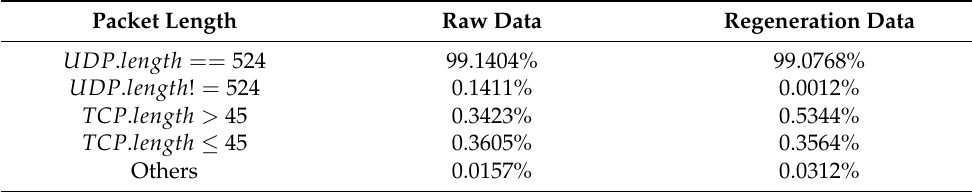
Table 5. Packet Length Proportion Information